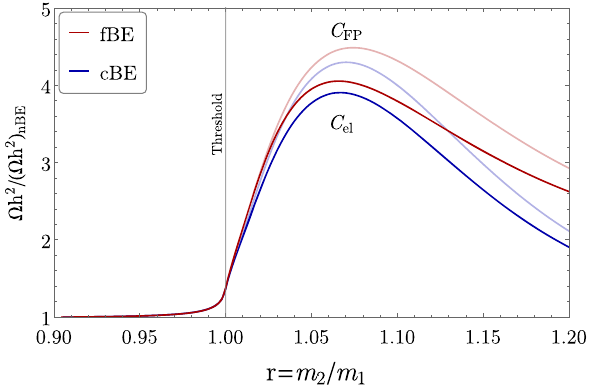
Fig. 7 Relicabundanceforthe sub-thresholdannihilation example,for afixedDMmassof m 1 = 100GeVandinfunctionofthefinalstatemass ratio r = m 2 / m 1 . The value of the φ 1 − φ 2 coupling, λ , is determined by the requirement (Ω χ h 2 ) nBE = Ω DM h 2 ; in the ‘forbidden’ region, for r > 1, λ is thus exponentially sensitive to r . Solid red (blue) lines correspond to results from the fBE ( cBE ) treatment based on the full scattering term of this example, while the corresponding results based on the small-momentum transfer approximation in Eq. (5) are plotted with lighter shading